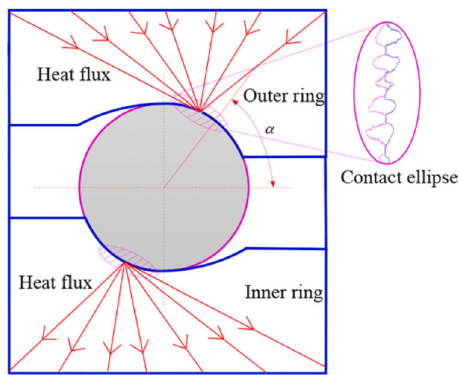
Fig. 70 The heat transfer mechanism of ball bearings [906].